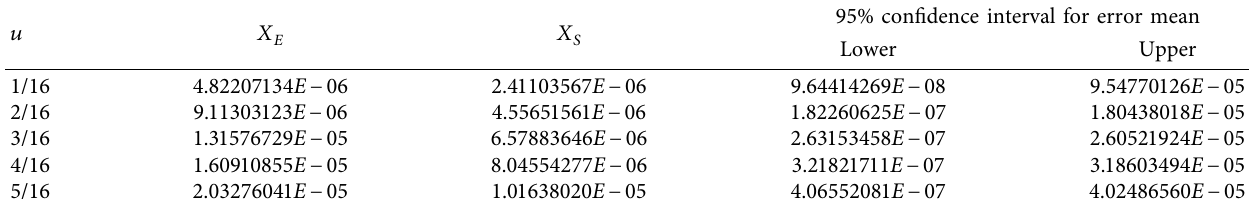
Table 3: When m � 16 and H � 0 . 6, the table exhibits numerical results of Example 2.